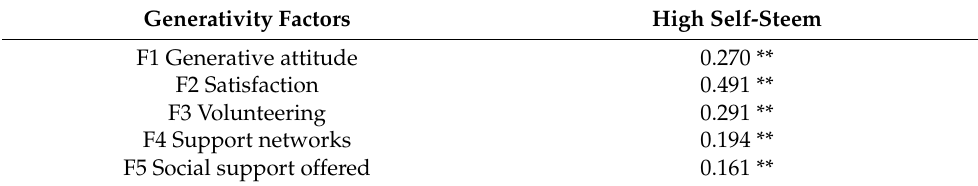
Table 5. Bivariate correlation of generativity factors and high